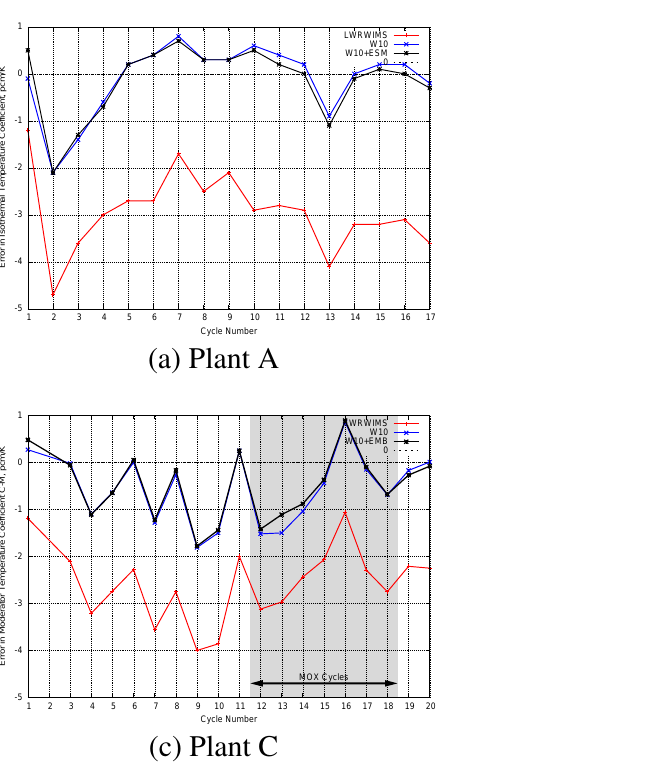
Figure 3: Isothermal Temperature Coefficients at BOC,